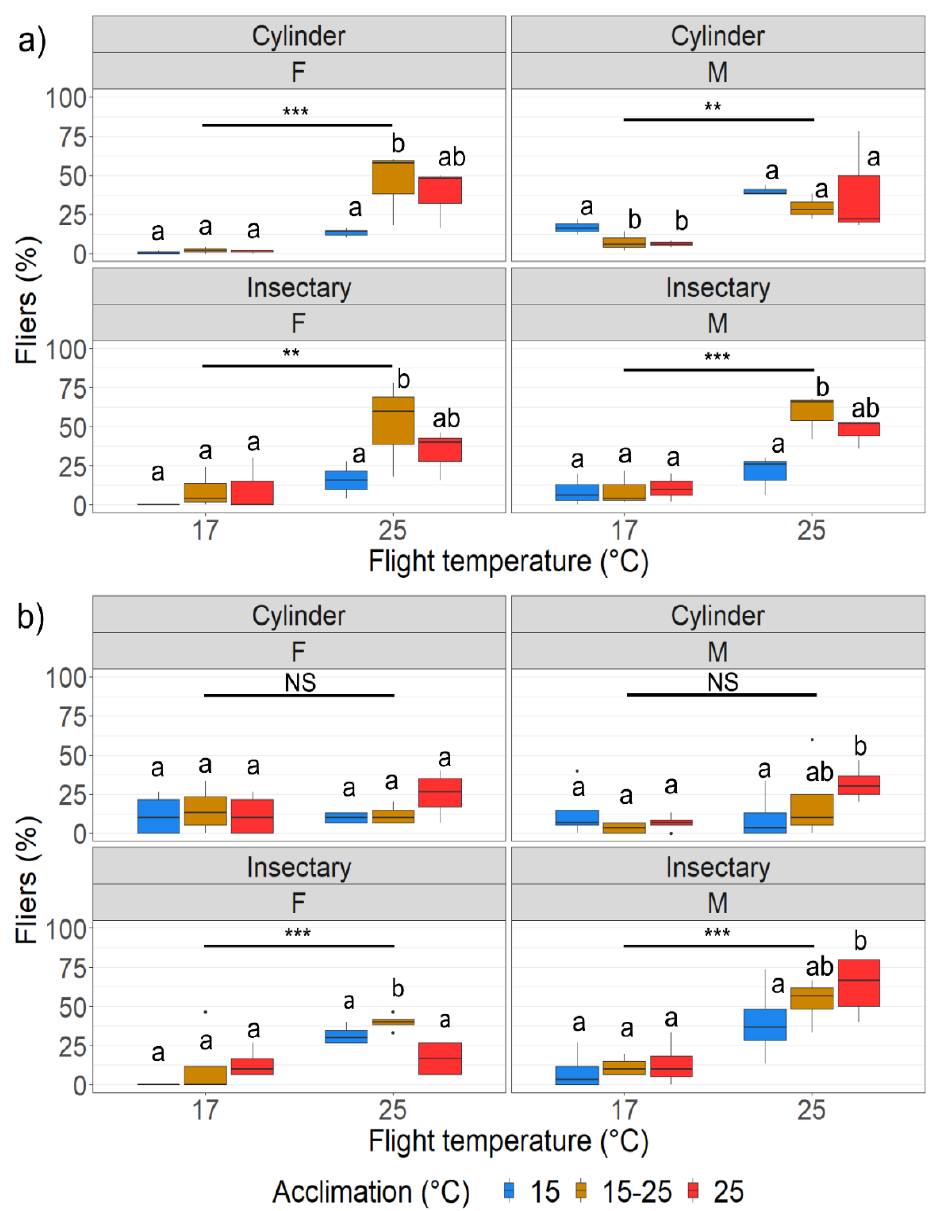
Figure 3. ( a ) Boxplot indicating median adult male (M) and female (F) fliers (%), upper and lower quantiles and maximum and minimum values (whiskers) for the two flight temperatures (17 and 25 °C), and adults from the larvae from the three larval acclimation temperatures (15, 15–25 and 25 °C) for the cylinder and insectary flight tests; ( b ) boxplot indicating subsequent adult male (M) and female (F) median fliers (%), upper and lower quantiles and maximum and minimum values (whiskers) after their exposure to chill coma for the two flight temperatures (17 and 25 °C) for adults from the larvae from the three larval acclimation temperatures (15, 15–25 and 25 °C) for the cylinder and insectary flight tests; significant differences between flight temperatures are indicated as: * = p < 0.05, ** = p < 0.001, *** = p < 0.0001, NS = not significant. Different letters indicate significant differences between acclimation temperatures per flight temperature.